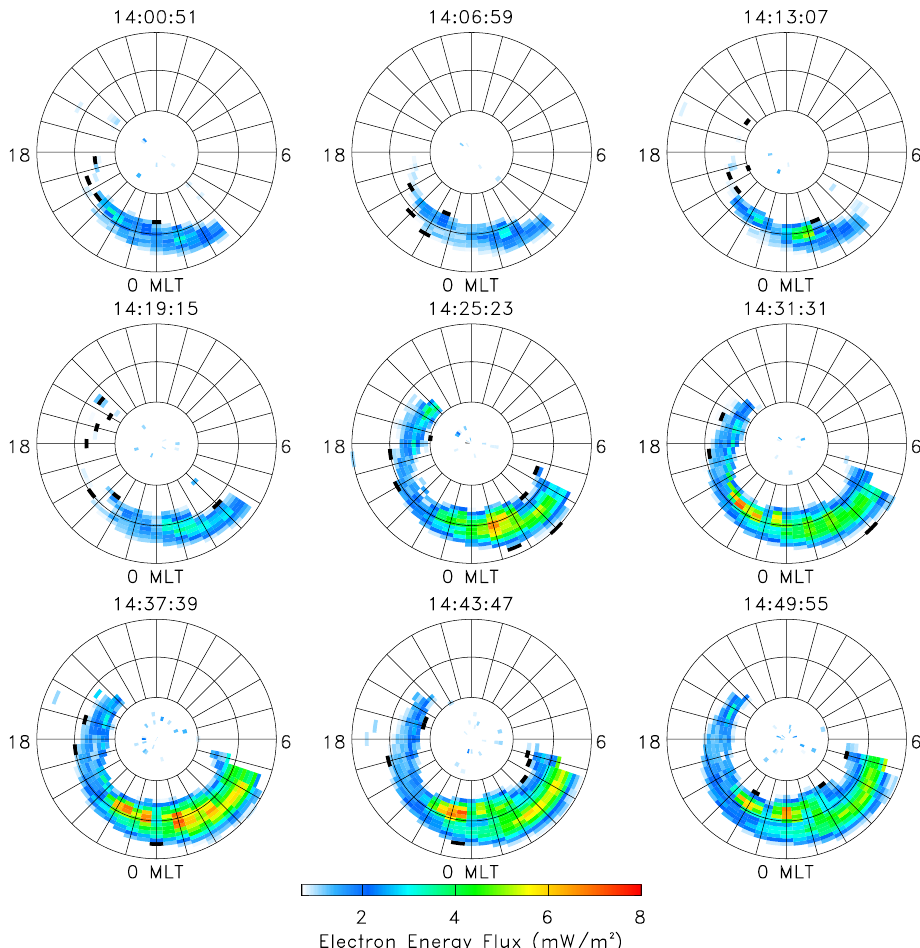
Fig. 4. POLAR UVI measurements for 6 January 1998. Nine images of derived electron energy flux are shown, one every ∼ 6min, starting at ∼ 14:01 UT (top left) until ∼ 14:50 UT (bottom right). An intensification is observed at all available MLTs at ∼ 14:25 UT (5th image), and a poleward expansion of the oval is observed on the nightside. The absence of dayside UV emissions in this plot is due to the limited field of view of the POLAR spacecraft. An enhancement of auroral precipitation was indeed observed in the dayside oval by the DMSP